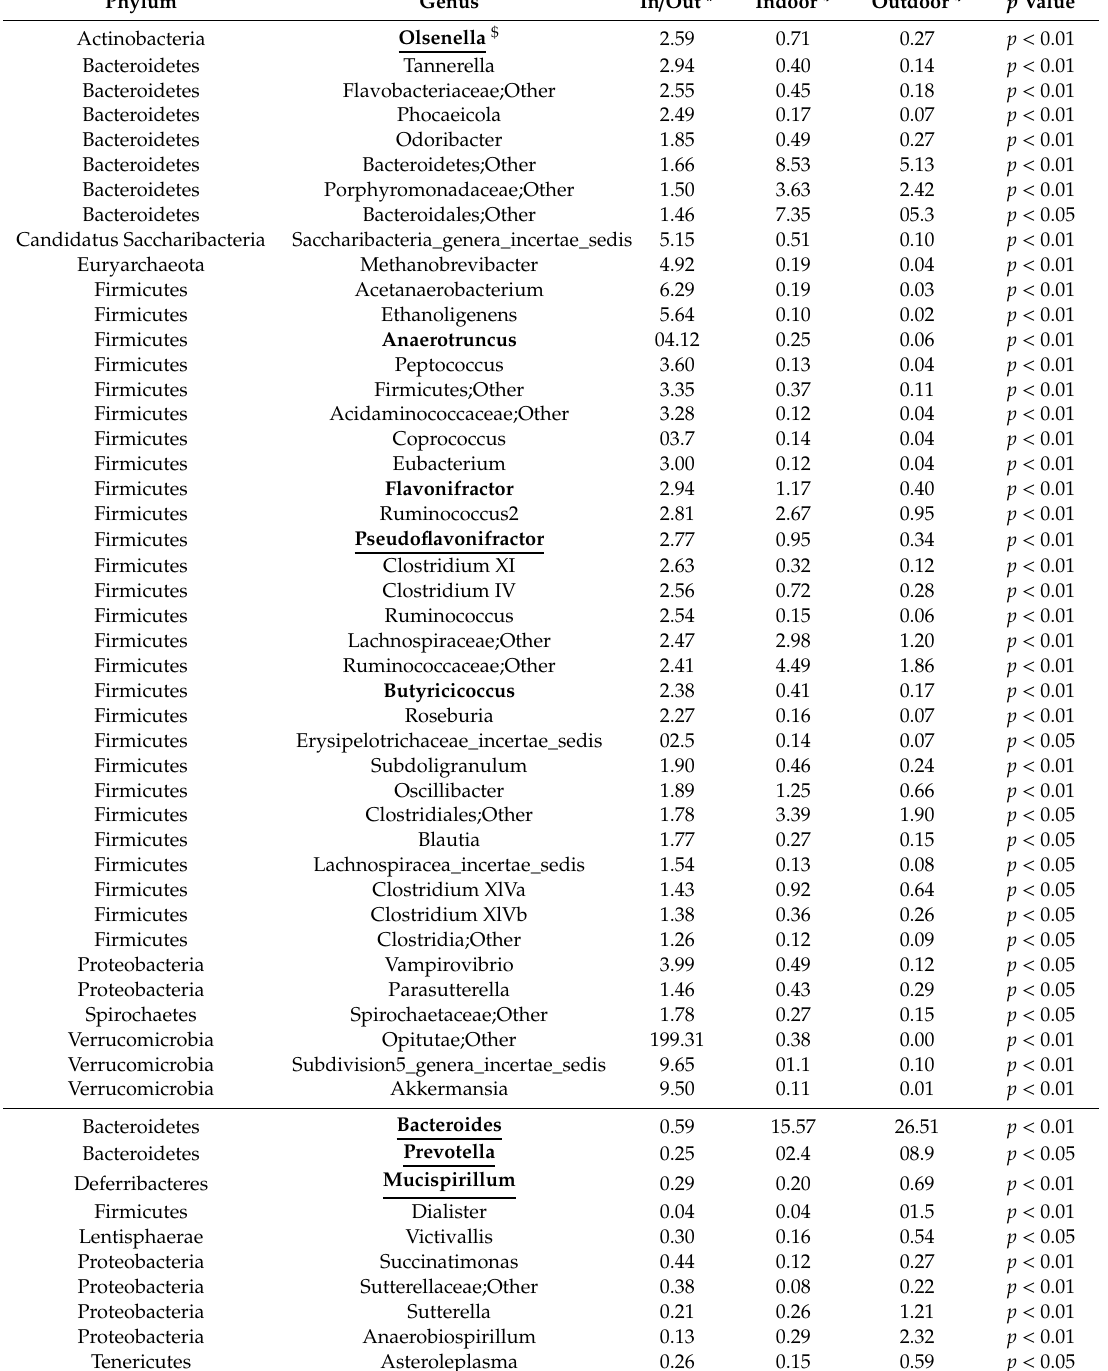
Table 1. Bacterial genera significantly more abundant either in microbiota of indoor or outdoor chickens.